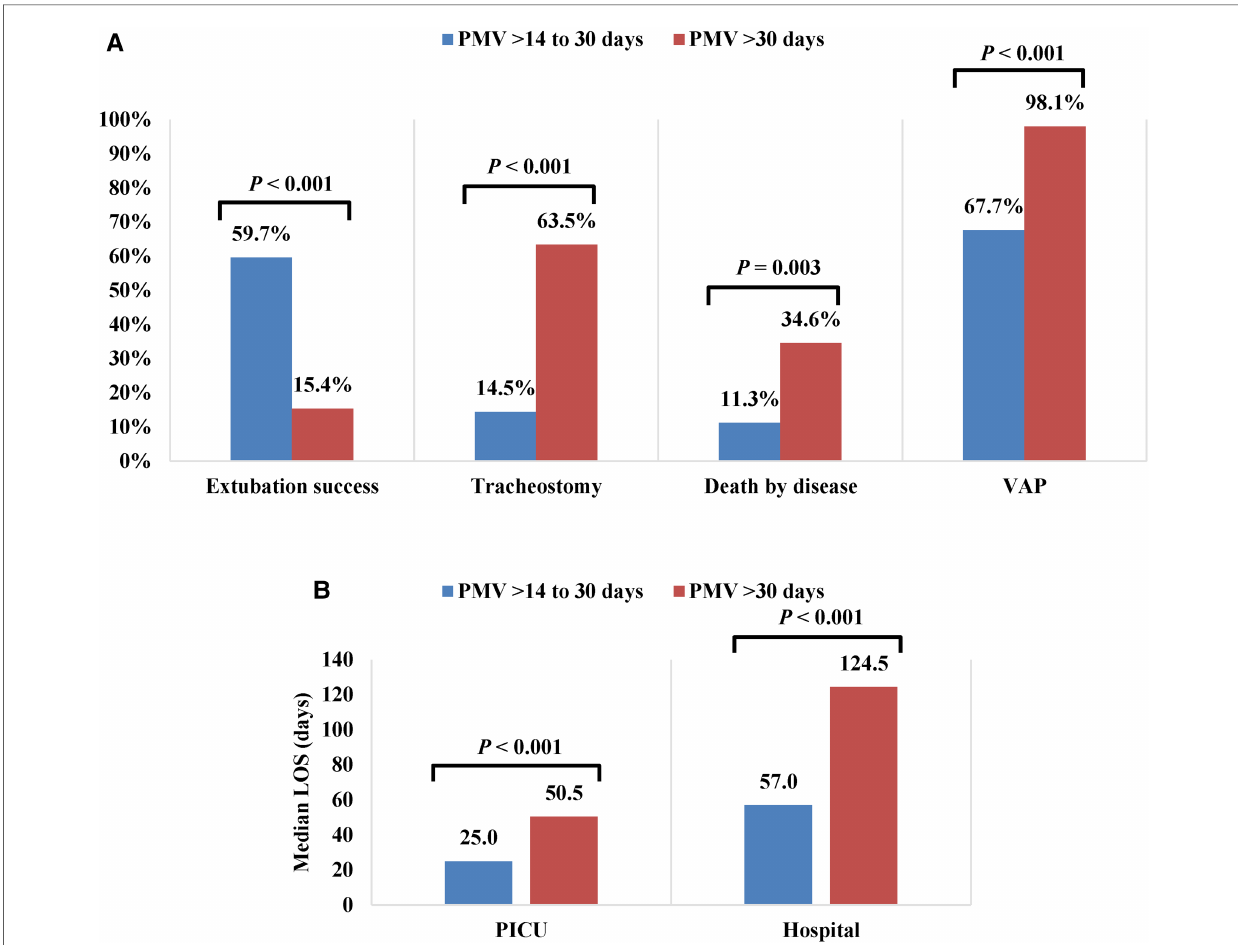
FIGURE 2 Outcomes of patients with PMV >14 to 30 days and PMV > 30 days ( A ) Percentage of extubation success, tracheotomy, death by disease and VAP ( B ) Median PICU and hospital LOS (days). PMV, Prolonged Mechanical Ventilation; VAP, Ventilator-Associated Pneumonia; LOS, Length Of